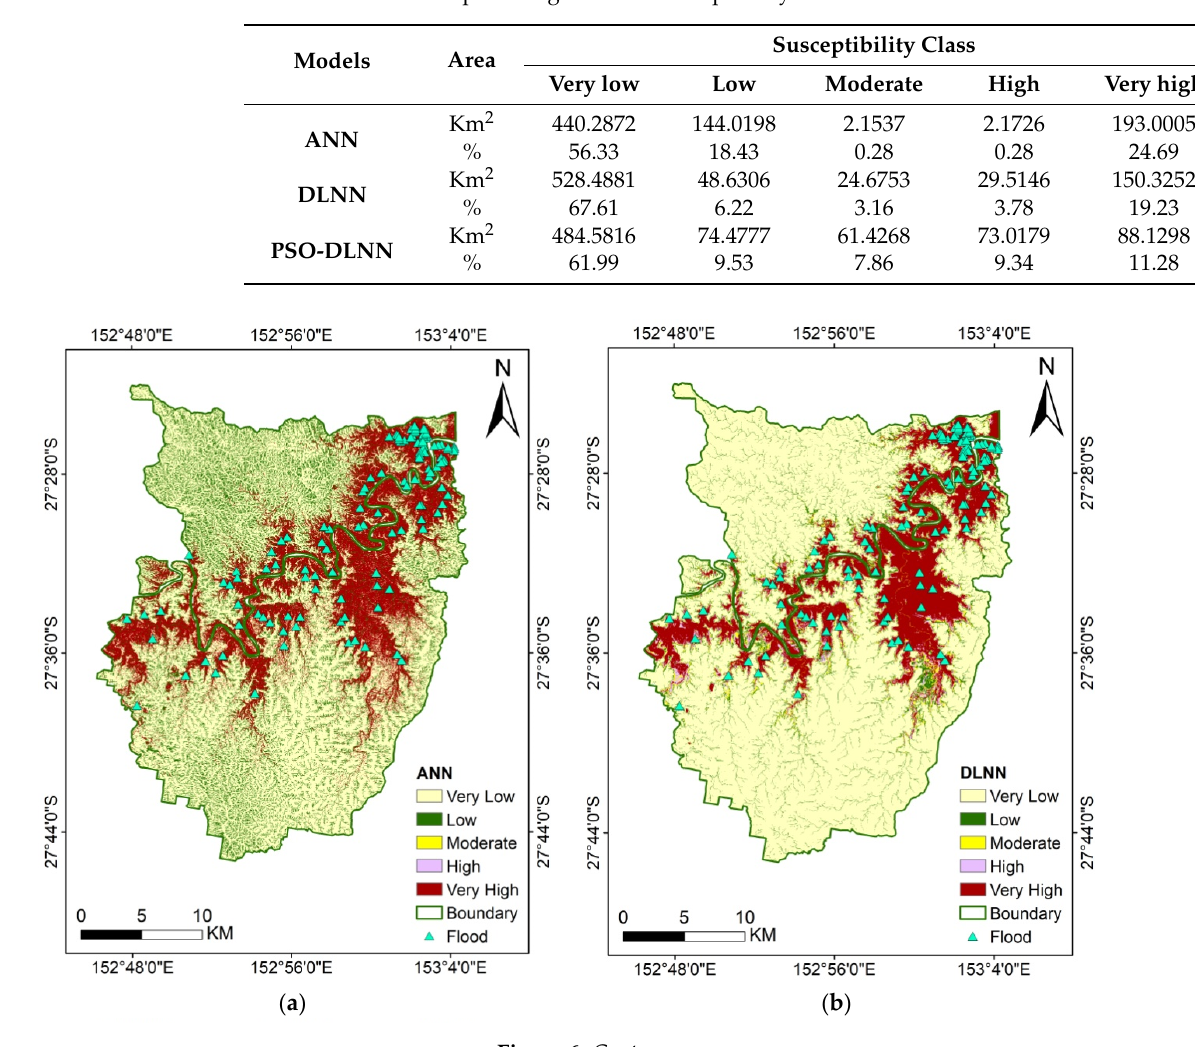
Table 5. The area and percentage of flood susceptibility classes.